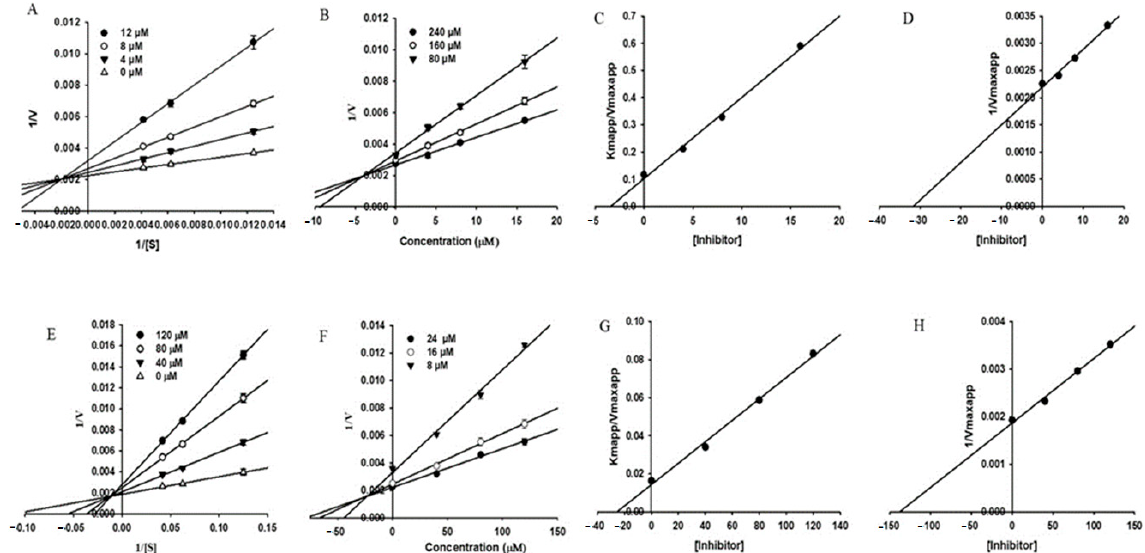
Figure 9. Lineweaver–Burk ( A , E ), Dixon ( B , F ) and secondary ( C , D , G , H ) plots of glycitein for acetyl- cholinesterase and butyrylcholinesterase inhibition, respectively. Reprinted with permission from Ref. [59]. Copyright 2021 ACS